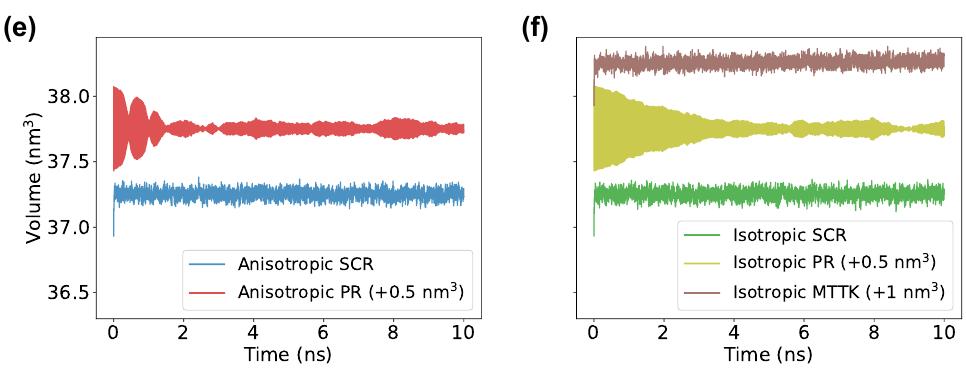
Figure 3. Volume average and fluctuations for a cubic Lennard-Jones crystal simulated with GRO- MACS. Panels ( a , b ) show the average volume using SCR, PR, and MTTK algorithms, in their anisotropic and isotropic variants, as indicated. Variance of the volume is reported in panels ( c , d ). Examples of non-converging volume trajectories for the PR barostat are shown in panels ( e , f ), for simulations carried out with τ P = 5 ps.